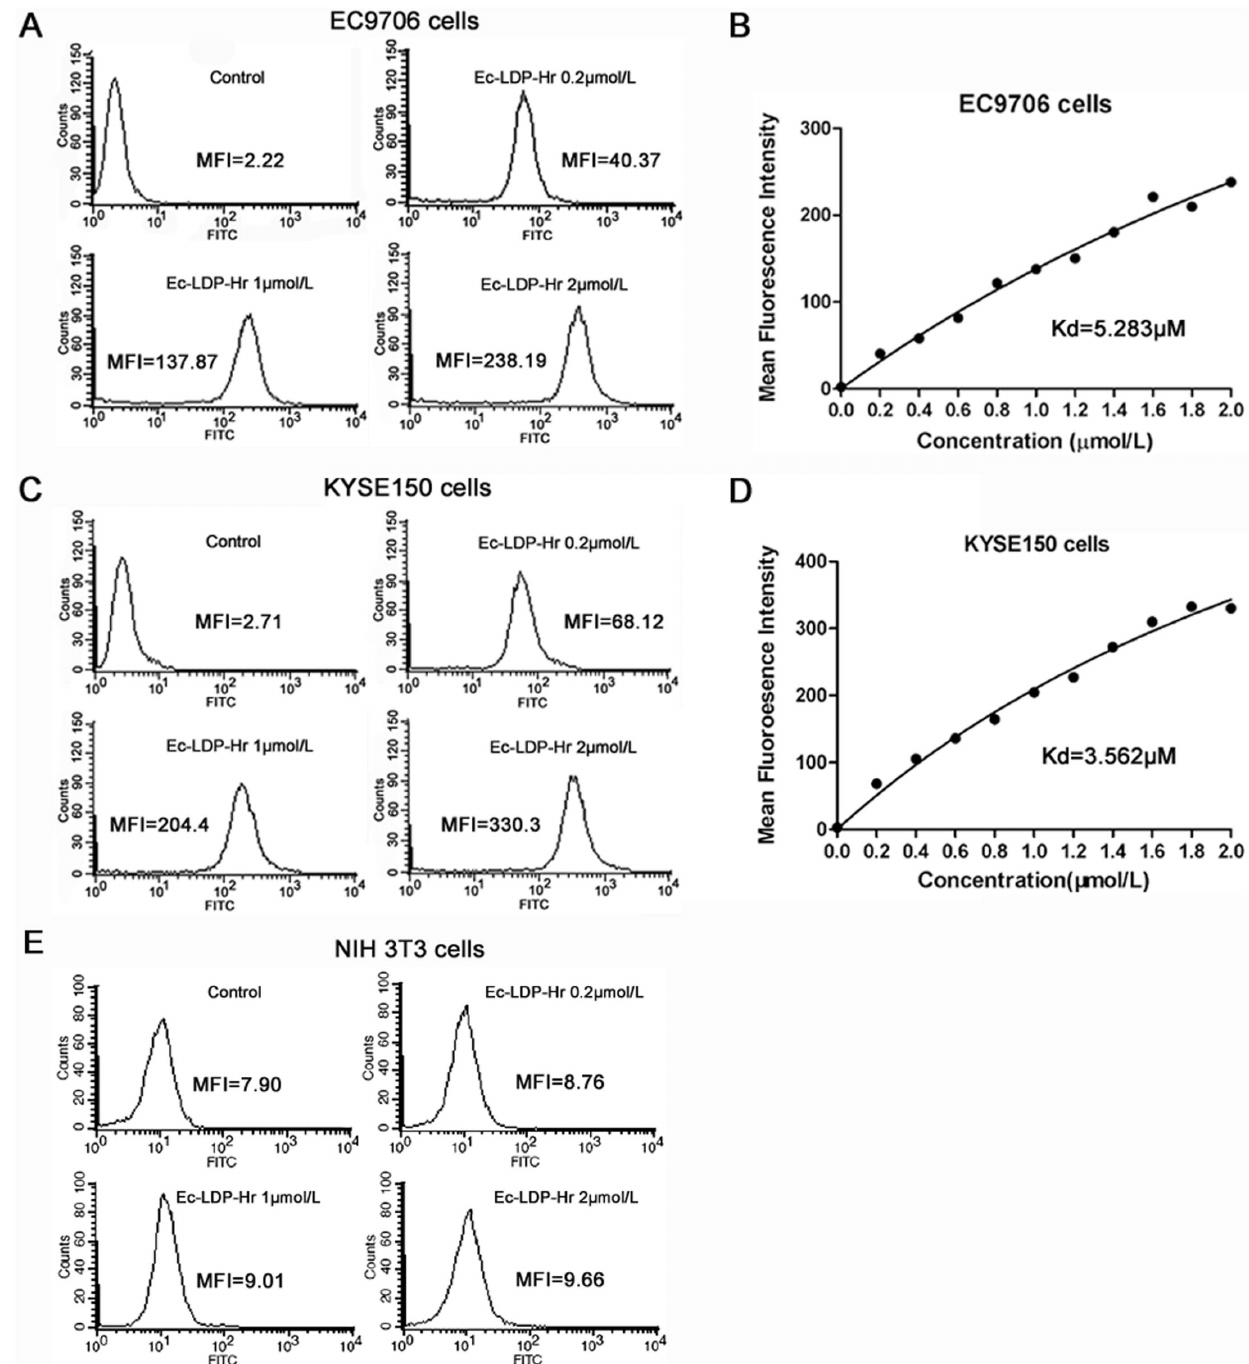
Figure 1. Binding affinity of Ec-LDP-Hr fusion protein to esophageal cancer cells. EC9706 cells (A), KYSE150 cells (C) or NIH 3T3 cells (E) were incubated with FITC-labeled Ec-LDP-Hr protein at indicated concentrations, and the mean fluorescence intensities (MFIs) were analyzed by flow cytometer. Increased concentrations of FITC-labeled Ec-LDP-Hr proteins were incubated with EC9706 cells (B) or KYSE150 cells (D). Following FACS, the MFIs were plotted versus protein concentrations.